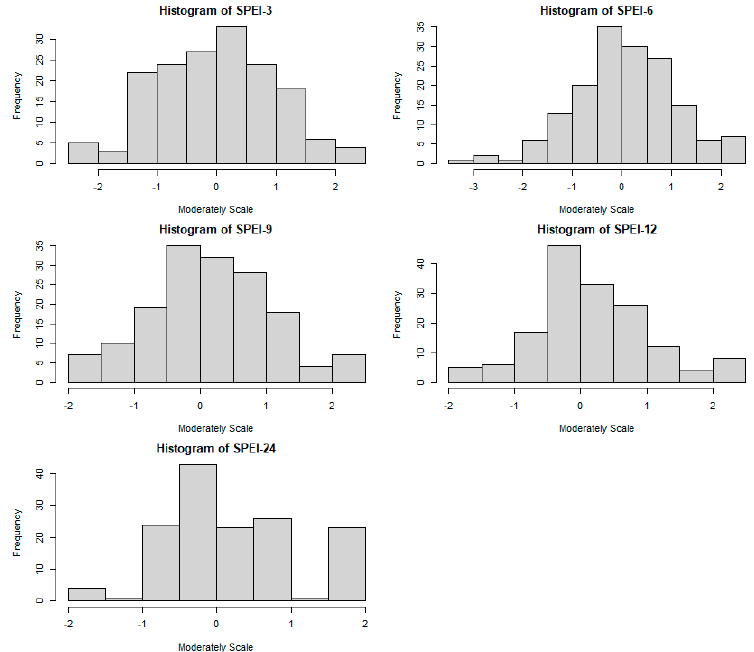
Figure 8. Residuals of SPEI- 3, 6, 9, 12 and 24 are normally distributed.